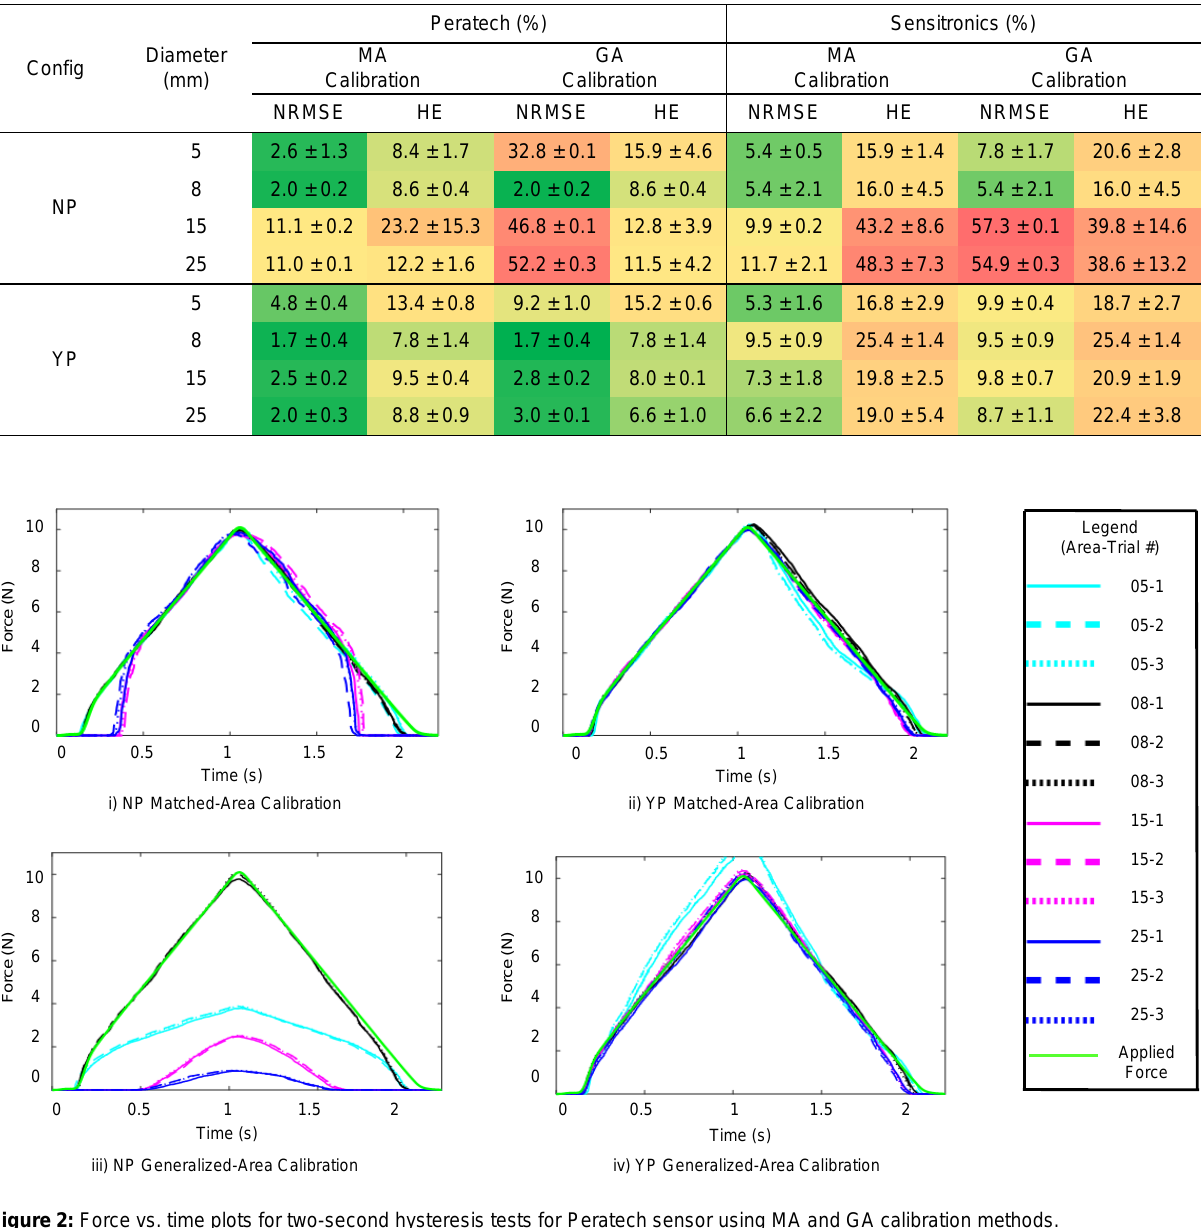
iii) NP Generalized-Area Calibration iv) YP Generalized-Area Calibration Figure 2: Force vs. time plots for two-second hysteresis tests for Peratech sensor using MA and GA calibration methods.